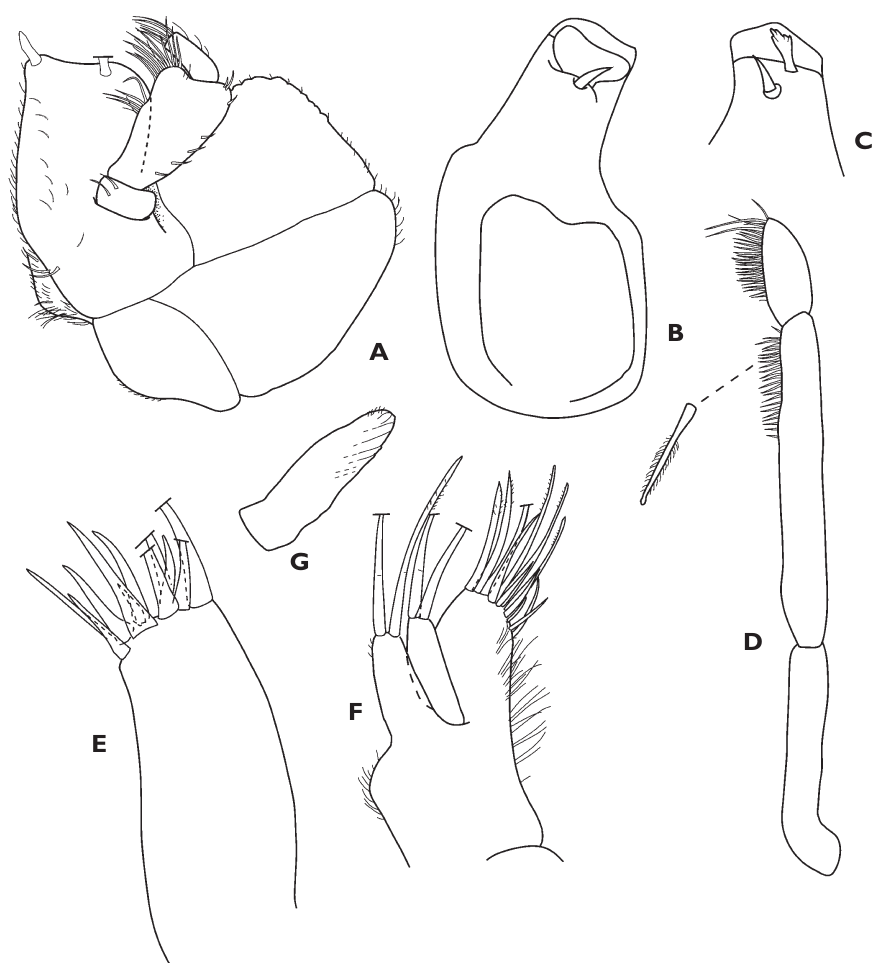
Figure 16. Myopiarolis norfanz sp. n. Paratype ♂ 10.7 mm. A maxilliped B left mandible C right mandible, distal margin D mandible palp E maxillule F maxilla G robust seta distal margin of maxilliped